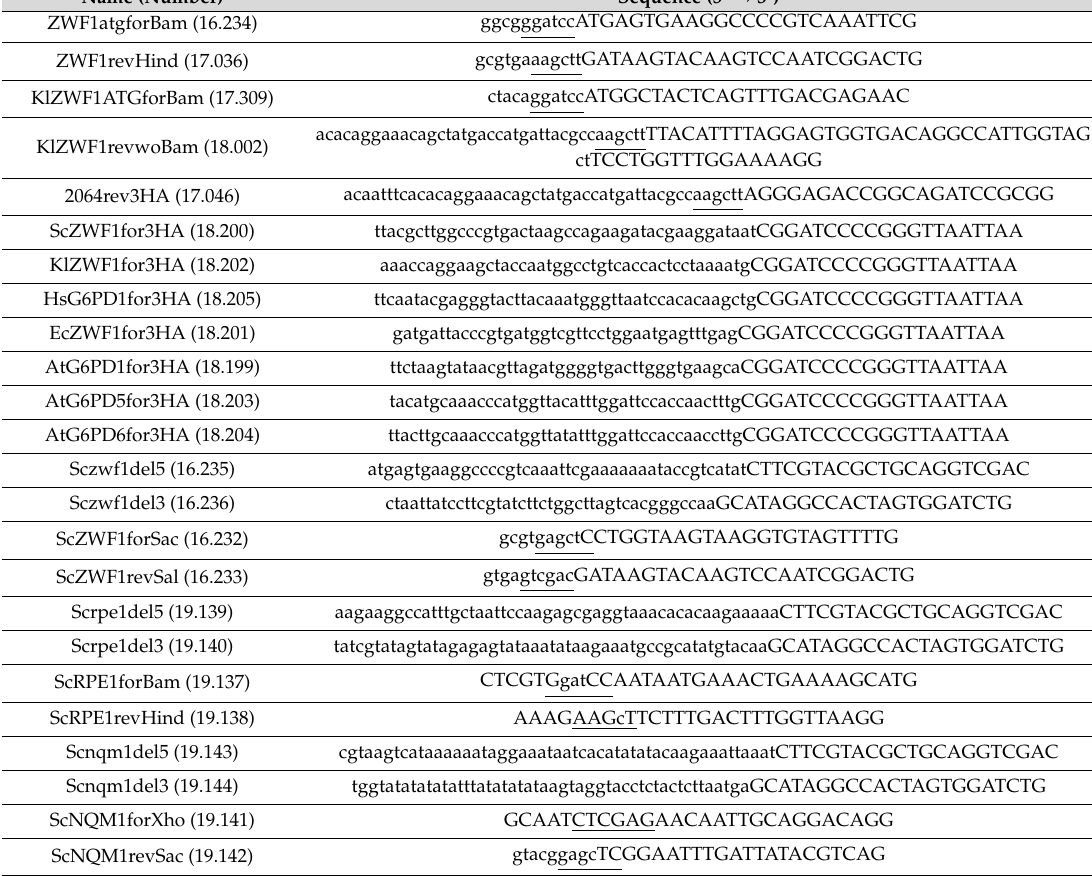
Table 1. Oligonucleotides used in this